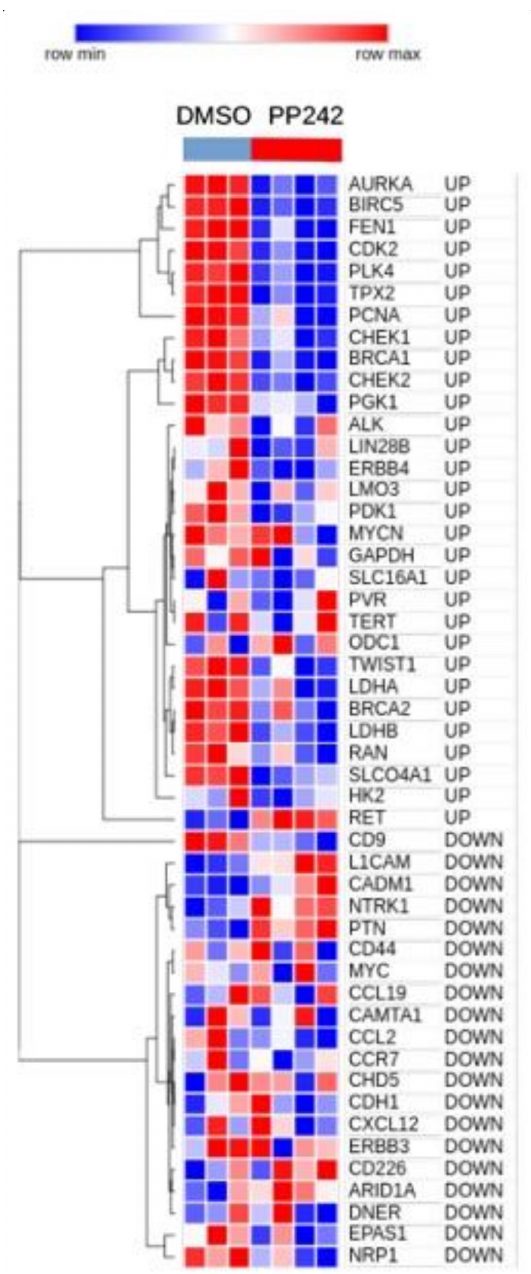
Figure 5. Heat map visualization of hypoxia-modulated genes in the gene expression profile of SK-N- BE(2)c NB cell lines treated with PP242 or dimethyl sulfoxide (DMSO). The heat map was generated using the Morpheus tool. The expression values for each gene modulated in hypoxic NB tumors (rows) are scaled and represented by pseudo-colors in the heat map. Red corresponds to high levels of expression and blue corresponds to low levels of expression. Experimental replicates (columns) are divided into two groups according to treatment. The two compounds used are indicated on top of the heat map. The expression of genes is grouped by hierarchical clustering. The dendrogram is shown on the left. Gene names and type of regulation in hypoxic NB tumors are shown on the